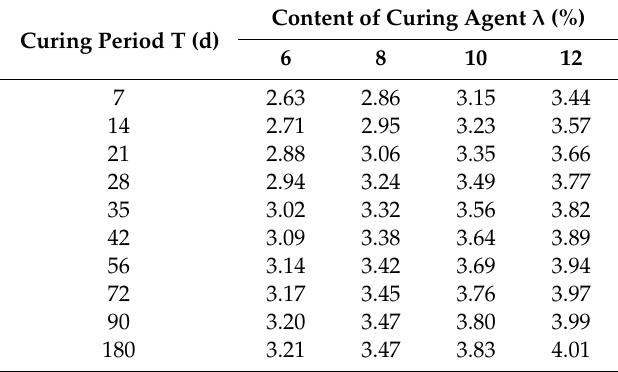
Table 4. The average equivalent particle size of the solidified calcareous sand ( µ m). Curing Period T (d)